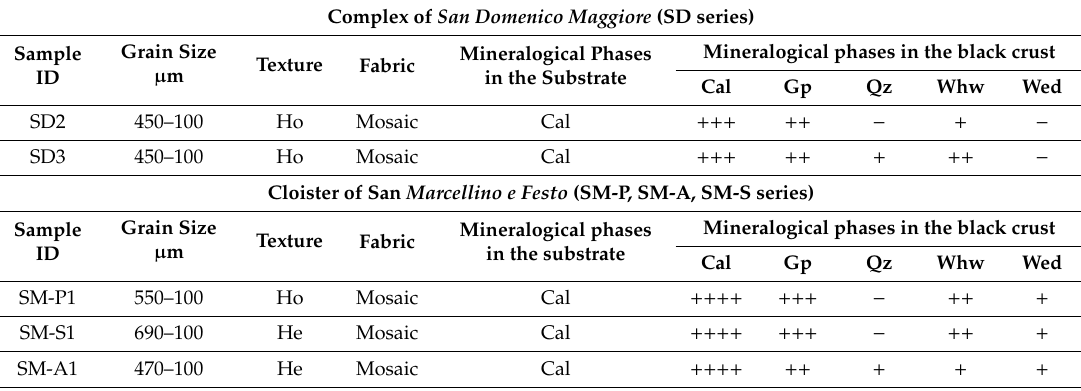
Table 2. Main textural features (OM) and mineralogical phases (XRPD) occurring in the analyzed samples, considering both unaltered substrate and black